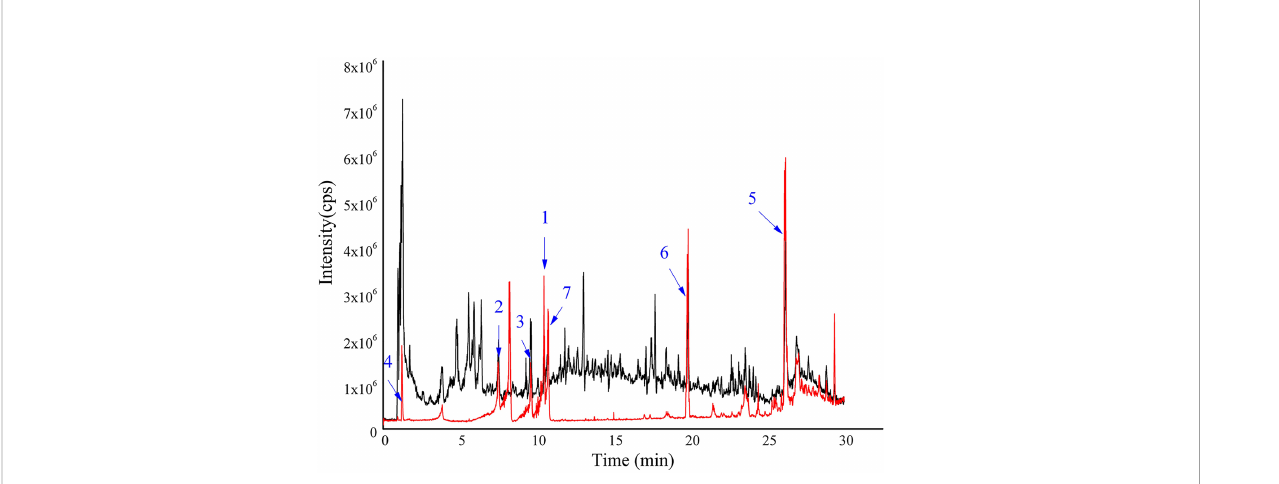
FIGURE 1 Total ion chromatograms of HDW and seven standards were obtained through UPLC-Q-TOF-MS/MS. HDW sample shown with black; mixed standards marked with red, 1-7 are scopoletin, asperuloside, p-coumaric acid, deacetylasperulosidic acid, ursolic Acid, 2-hydroxy-3- methylanthraquinone and rutin,